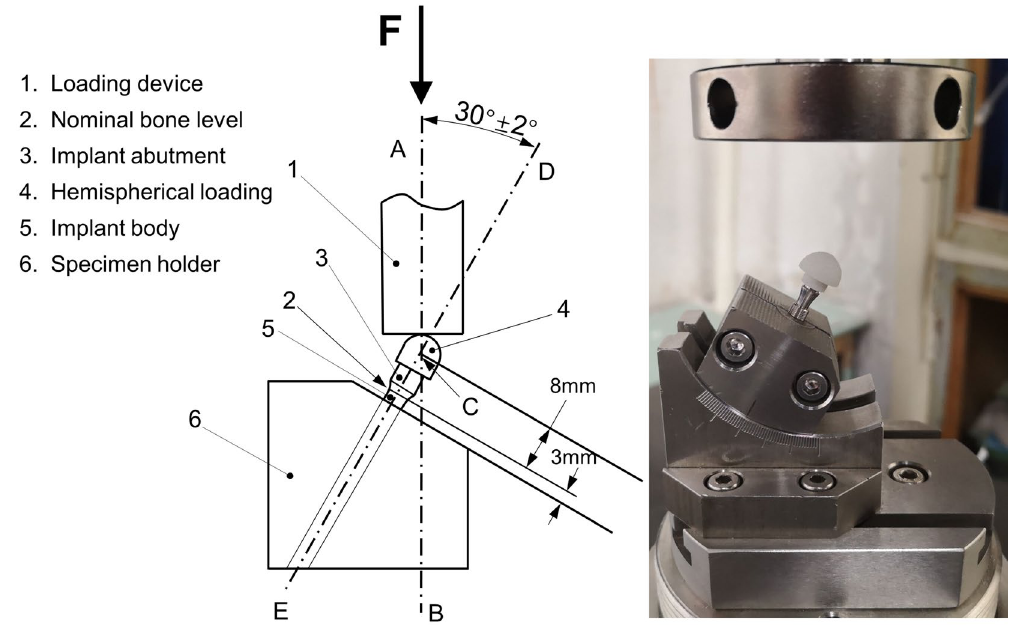
Figure 2. Schematic of the test setup and loading